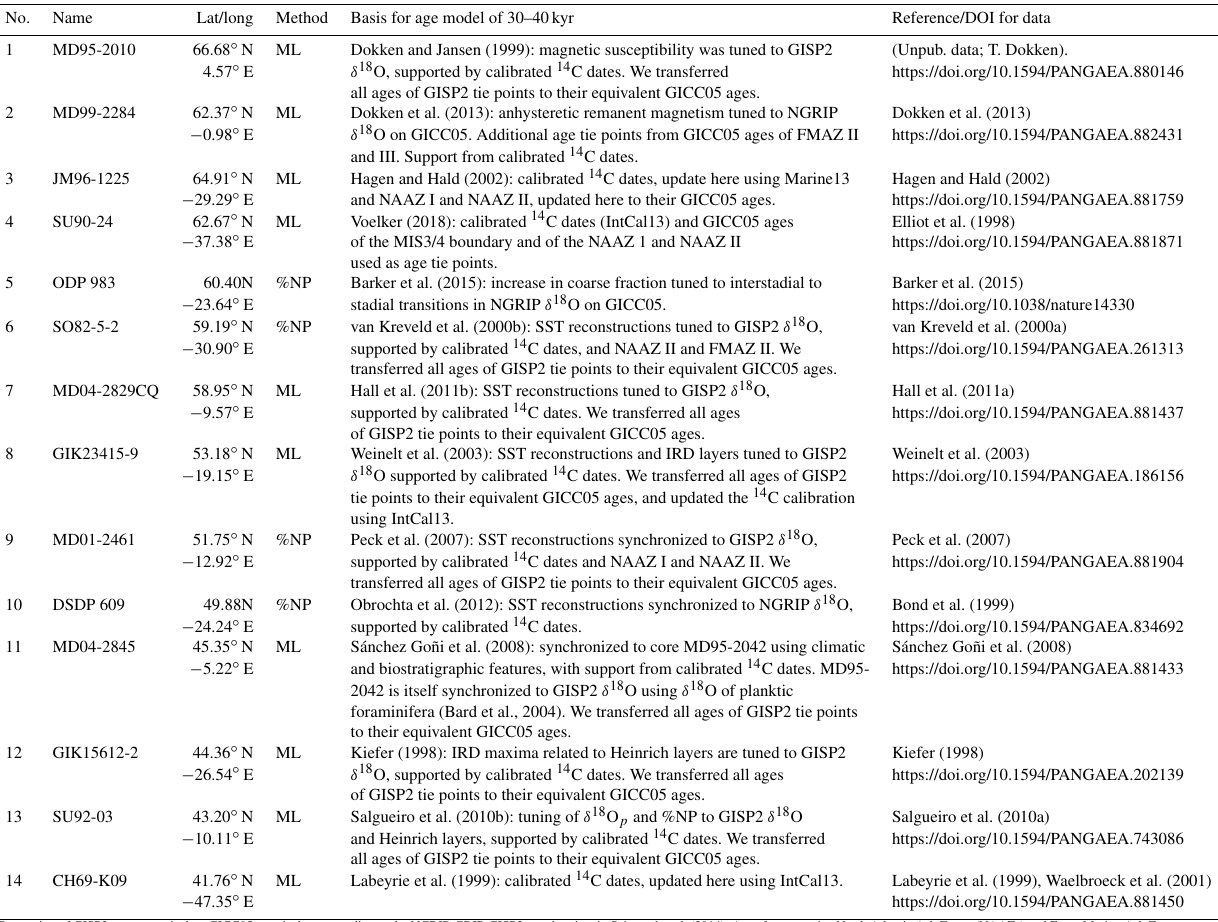
Table 1. Core sites and age model